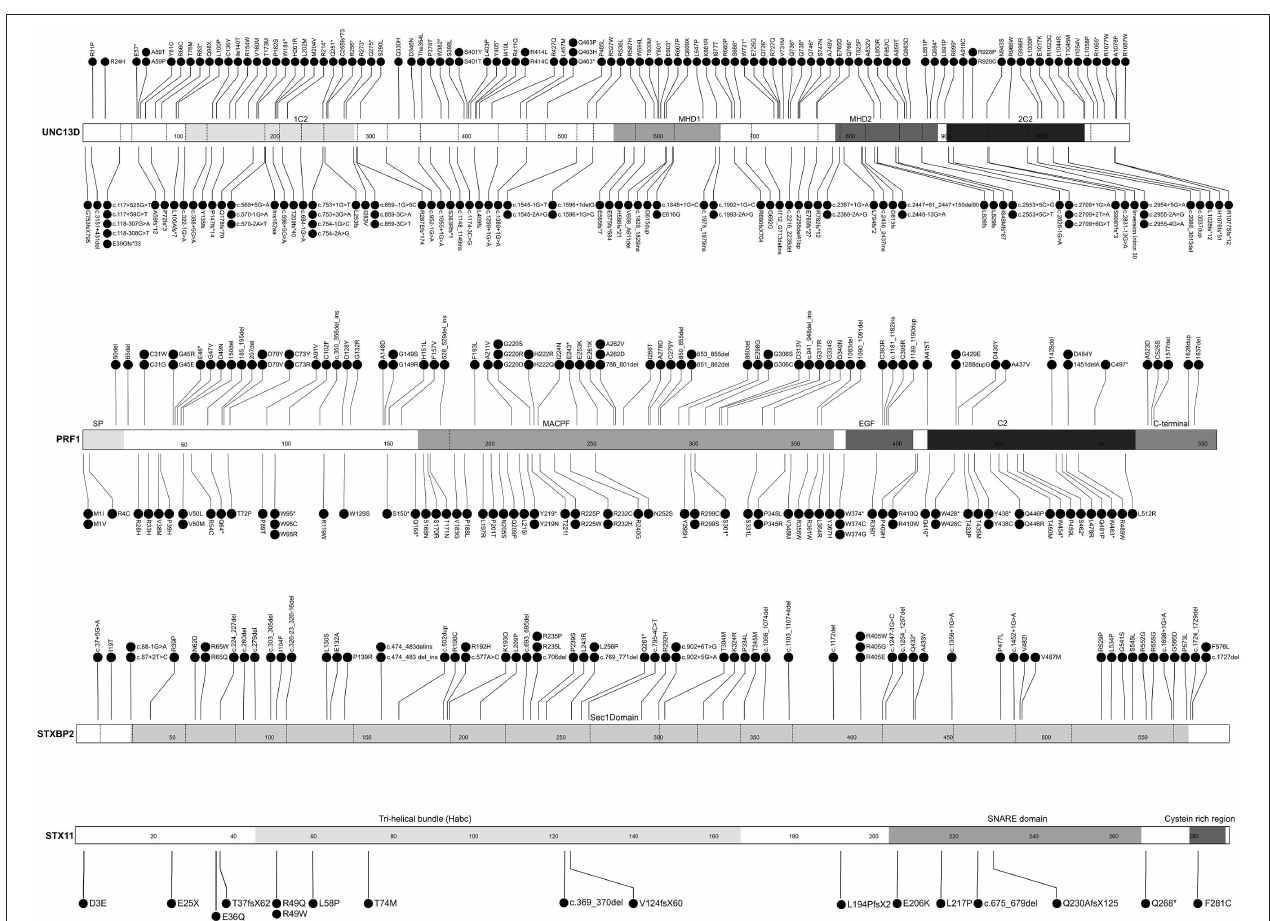
FIGURE 2 | FHLdb genetic variants in the UNC13D , PRF1 , STXBP2, and STX11 genes. Linear representation of UNC13D, PRF1, STXBP2, and STX11 at the protein level. The diagram shows the distribution and location of all variants reported in FHLdb, except for large genomic rearrangements. Dotted lines delimitate each exon. Functional domains are indicated above each gray-scale colored square. MHD1 and MHD2, Munc13 homology domains 1 and 2; SP, signal peptide; MACPF, perforin membrane attack complex; EGF, epidermal growth factor-like; C2, calcium binding domain. The figure was designed using the Protein Paint free software included in the St. Jude PeCan Data Portal (https://pecan.stjude.cloud) (